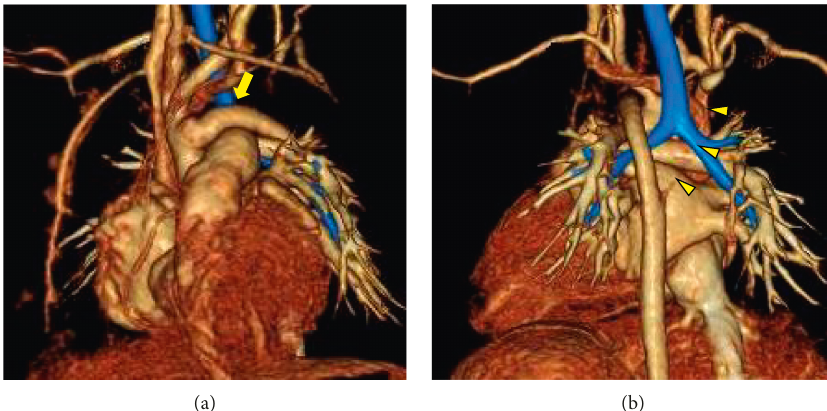
Figure 3: (a, b) Contrast-enhanced three-dimensional CT images obtained 21 days after surgery. (a) The front view and (b) the rear view. There is no stenosis in the reconstructed left aortic arch (yellow arrow) and the right distal arch is regressed (small yellow